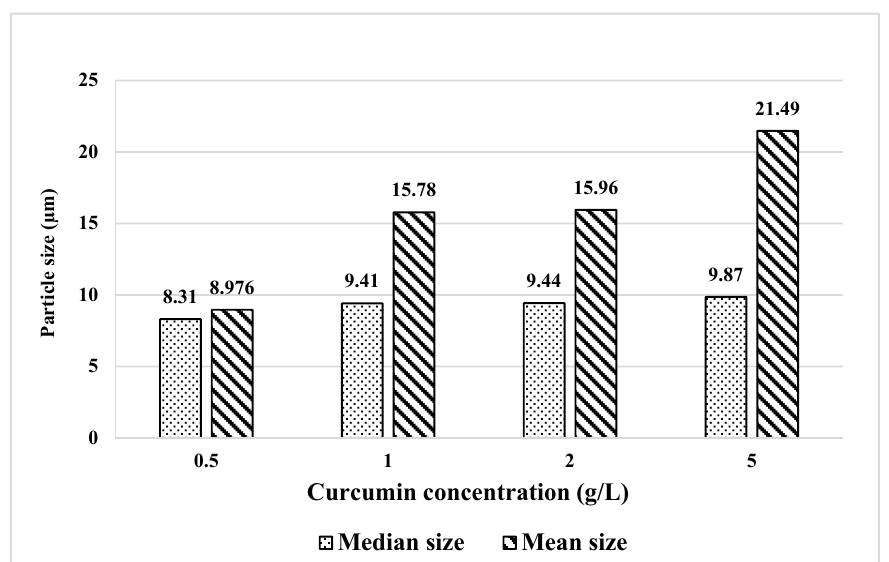
Figure 4. Effect of different curcumin concentrations on particle size of suspensions. Figure 4. E ff ect of di ff erent curcumin concentrations on particle size of suspensions.